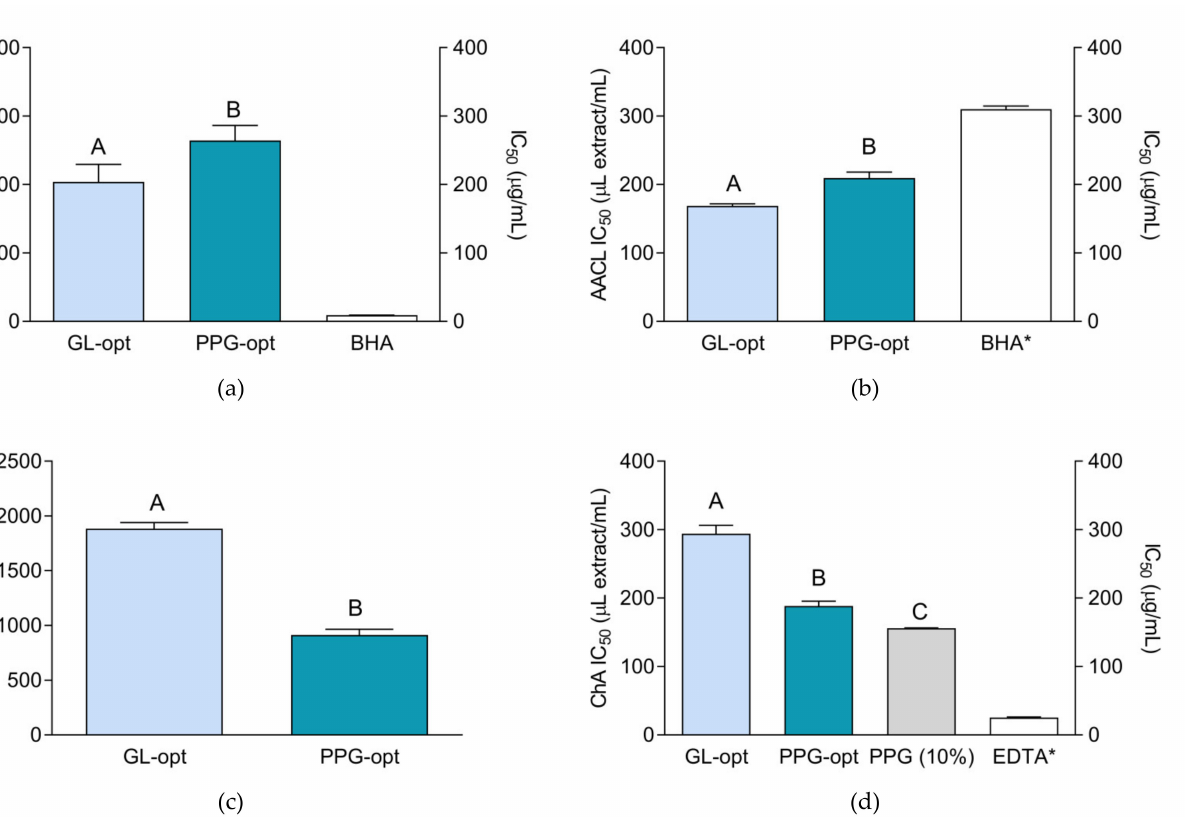
Figure 2. Antioxidant activity of the extracts and positive controls: BHA (butylated hydroxyanisole) and EDTA (ethylenedi- aminetetraacetic acid): ( a ) radical scavenging activity (RSA); ( b ) the antioxidant activity in β -carotene-linoleic acid assay (AACL); ( c ) activity in the ORAC assay expressed as trolox equivalents (TE) and ( d ) chelating activity (ChA). The activity is expressed as IC 50 value ( a , b , d ) and Trolox equivalents (TE) ( c ). Asterisk (*) indicates that the IC 50 unit is placed on the right y -axis. Different uppercase letters indicate statistically significant difference ( p <